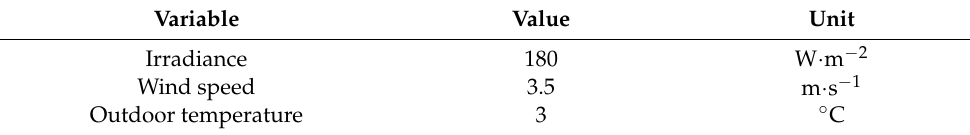
Table 4. Boundary condition for the CFD model.